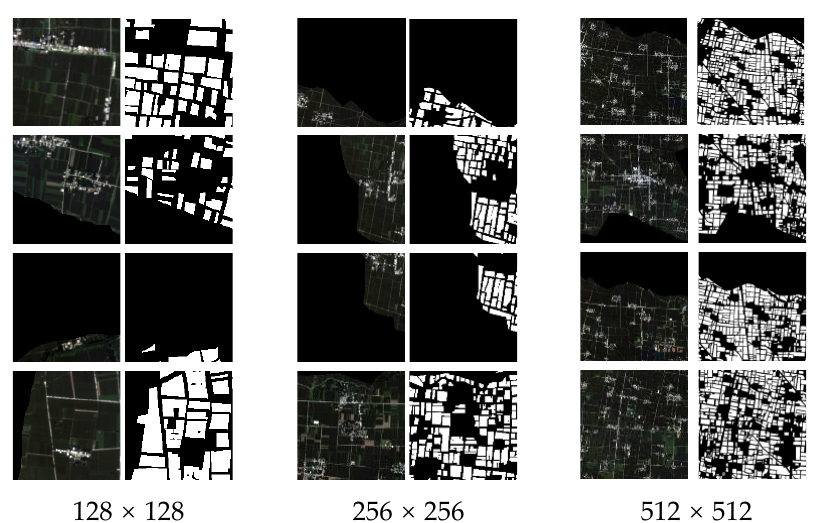
Figure 2. Comparison of three image cropping sizes of 128 × 128, 256 × 256, and 512 × 512 px. (2)